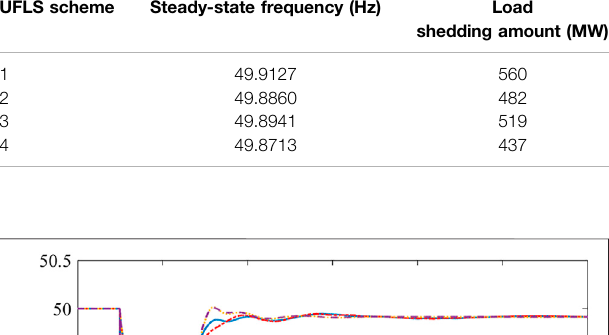
FIGURE 9 | Frequency curves under different UFLS schemes considering different virtual inertia control modes.